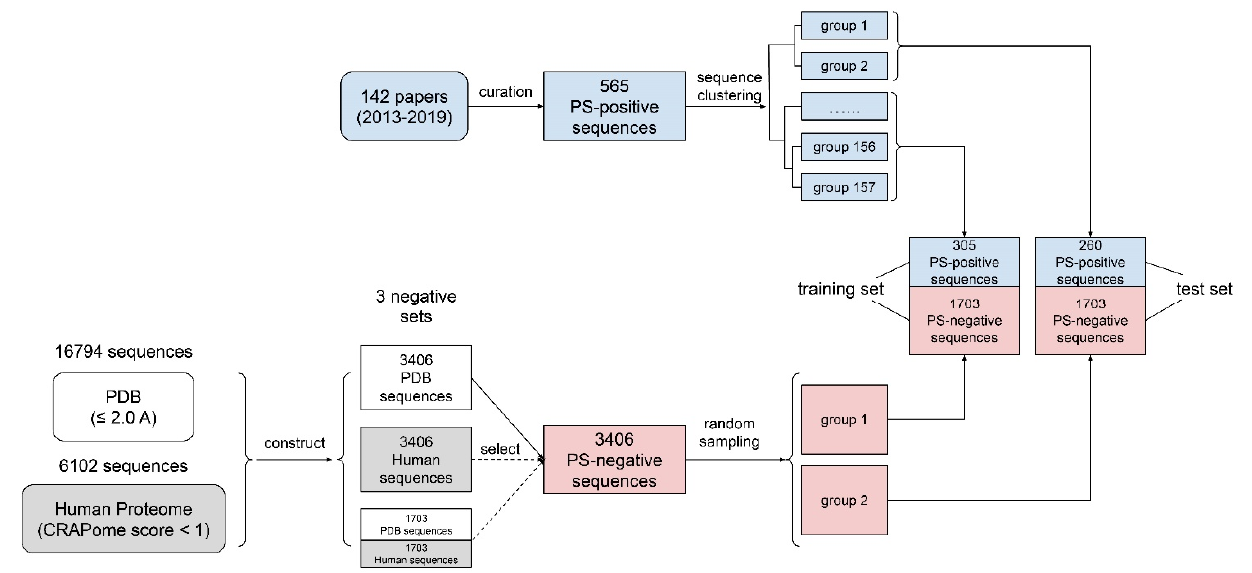
Figure 1. Data curation workflow. A schematic diagram of how data for training were obtained and processed.